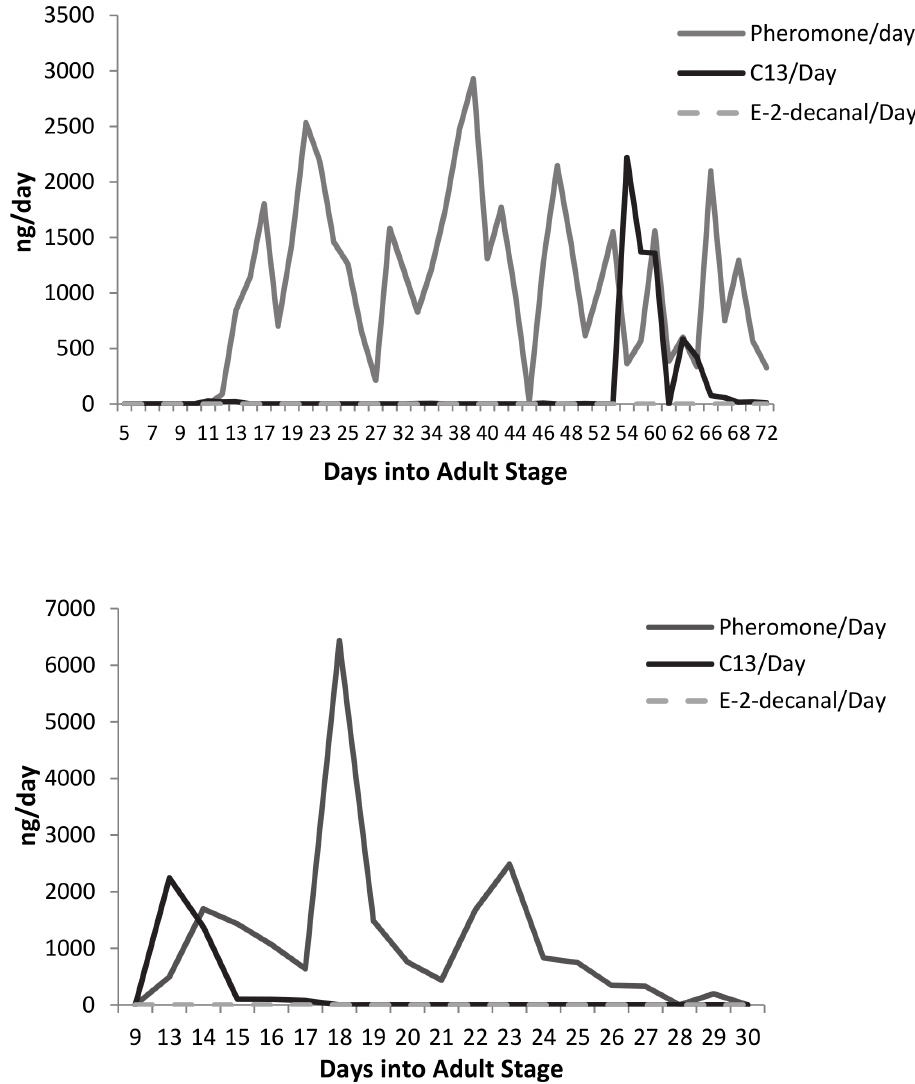
Fig 1. Pheromone/C13/ E -2-decenal cycling for single male. The average ± SE start age of pheromone emission: 12.71 days ± 1.00 (n = 28). Start age of pheromone emission did not significantly vary by the age that males were placed in the jar (ages 5 – 12 days, n = 28). Pheromone emission was peaked every 3.04 ± 0.08 days, with an average of 3.33 ± 0.27 peaks per male. C13 and E -2-decenal emissions lasted longer 6.90 ± 0.53 days for C13, and 6.64 ± 0.80 days for E -2-decenal. C13 and E -2-decenal usually do not show repeated peaking trend, with average number of peaks being 1.91 ± 0.16 for C13 and 0.64 ± 0.16 for E - 2-decenal (n = 84 males). (A) Example of cyclic pheromone and C13 peaks for a male held singly and placed in aeration chamber five days into the adult stage. (B) A male removed from an all-male holding cage and placed in an aeration chamber on day 9. − 6.634; p < 0.0001; C13 for Compound = subject, # males (subject). Pheromone F 1,71 − 5.701; p = 0.001; E -2-decenal F − 1.617; p = 0.003. Regression equations: Pheromone = F 1,71 1,71 -0.17x + 2.52; C13 = 0.22x + 1.15; E -2-decenal = -0.773x + 0.290. The relationship between C13 and the male-specific compounds was analyzed via ANOVA using pairwise correlations. Pairwise correlations, p < 0.0001. The C13 and male specific compounds interaction overlaps at 2.5 males.